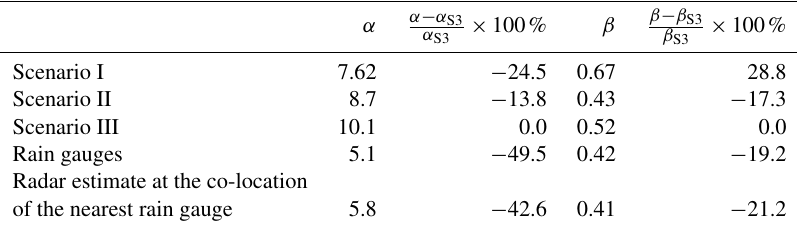
Table 6. Parameters of the identified ID thresholds and relative